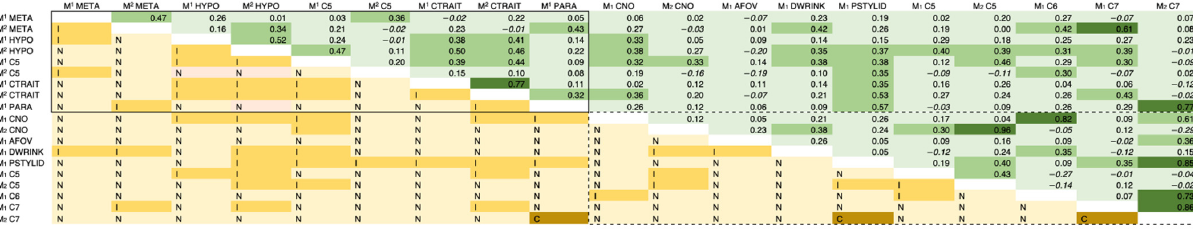
Figure 2. Genetic correlation matrix for permanent molar morphology. Correlation estimates are shown above the diagonal with positive values nonitalicized and negative values italicized. Cells are shaded based on absolute estimate values (<0.3 = light green; 0.3-0.6 = green; >0.6 = dark green). Pleiotropy-based model likelihood results are shown below the diagonal (N = no pleiotropy; I = incomplete pleiotropy; C = complete pleiotropy). Cells are shaded based on degree of pleiotropy (N = light yellow; I = yellow; C = dark yellow). Model results for within-arcade trait pairs are enclosed in boxes. Maxillary trait pairs are outlined with a solid line, and mandibular trait pairs are outlined with a dotted line. For trait names and abbreviations, see Table 1.